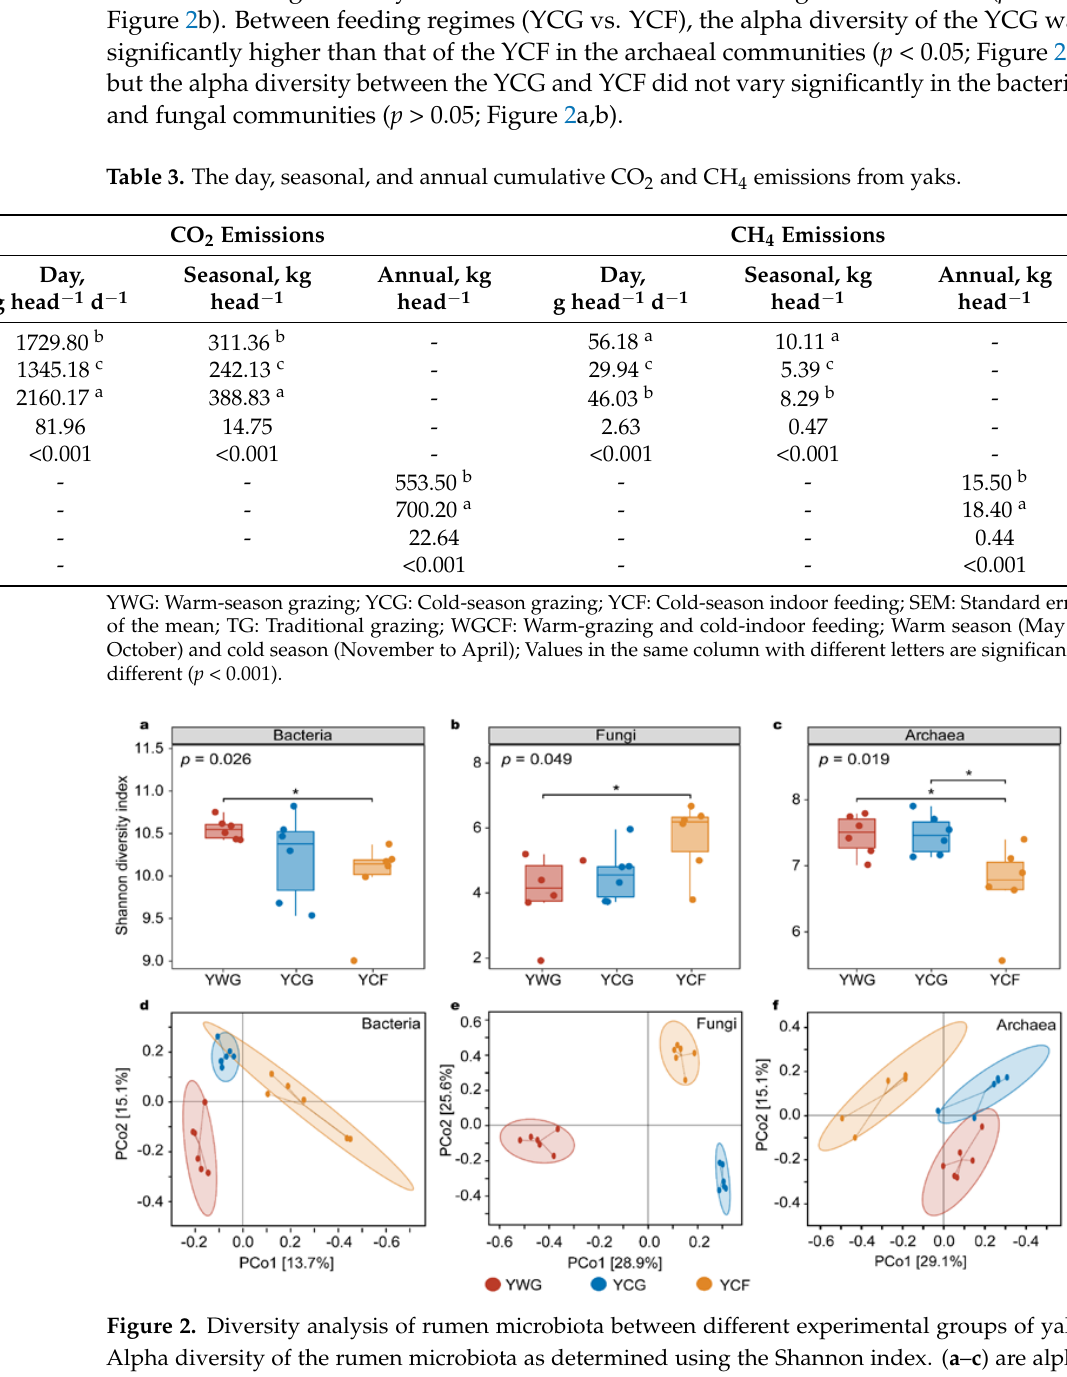
Figure 3. Phylum-level distribution of the rumen bacteria ( a ), fungi ( b ), and archaea ( c ) in three groups. Relative abundance of top 10 for rumen microbiota of yaks. YWG: Warm-season grazing, YCG: Cold-season grazing, YCF: Cold-season indoor feeding.